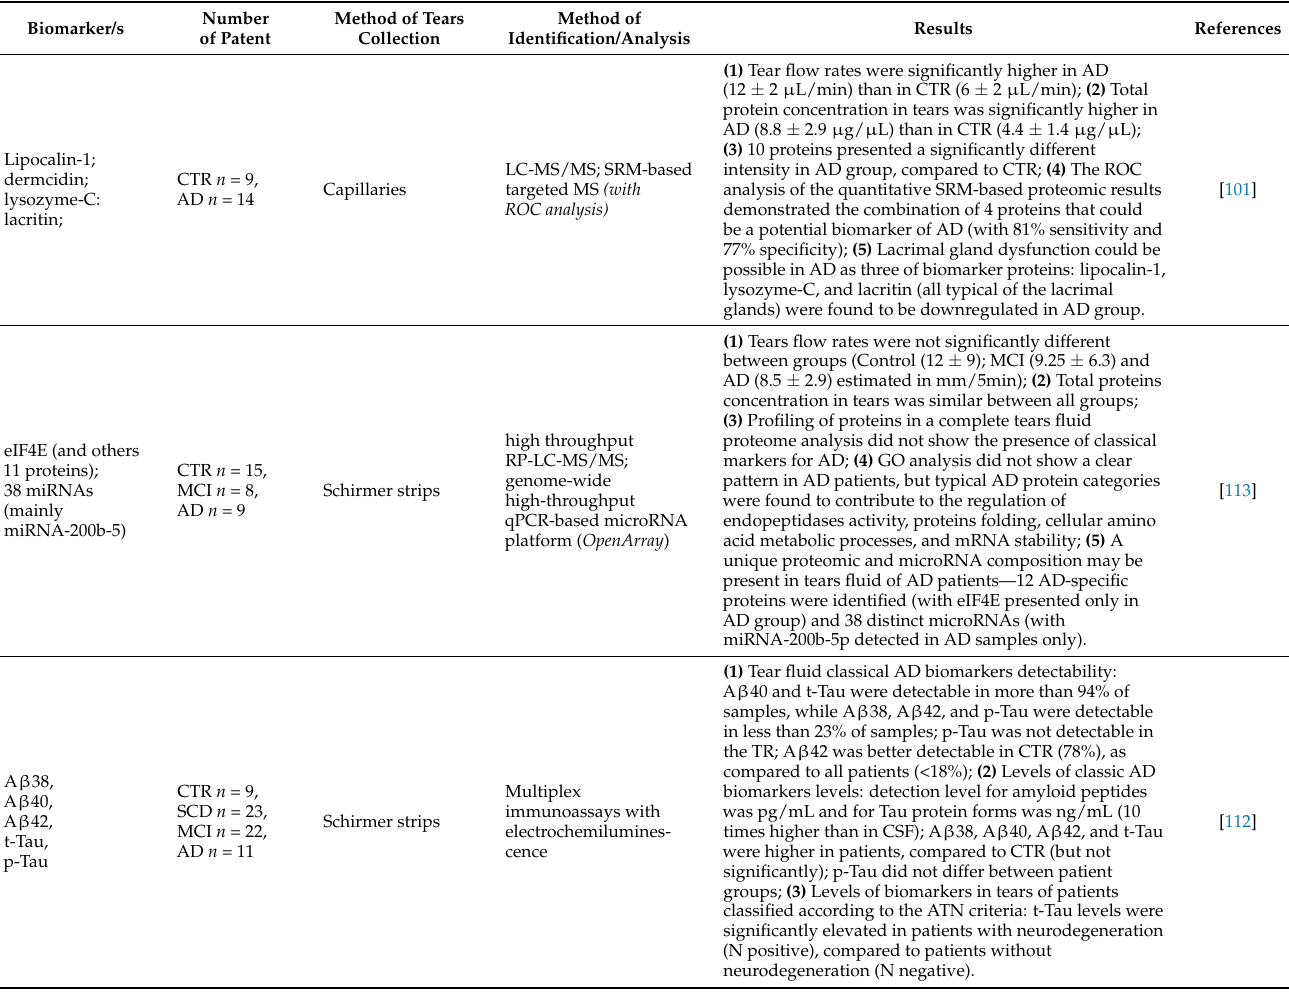
Table 3. Characteristic of biomarkers in Alzheimer’s